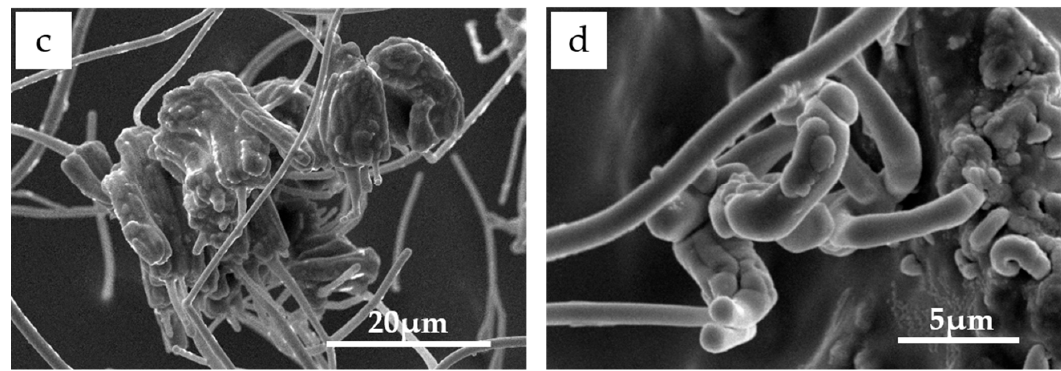
Figure 6. SEM images of the oily polluted soils and rope collected from the Atake seashore in May 2017, showing filamentous microorganisms ( a ) and coccus-type bacterial colonies ( b – d ).